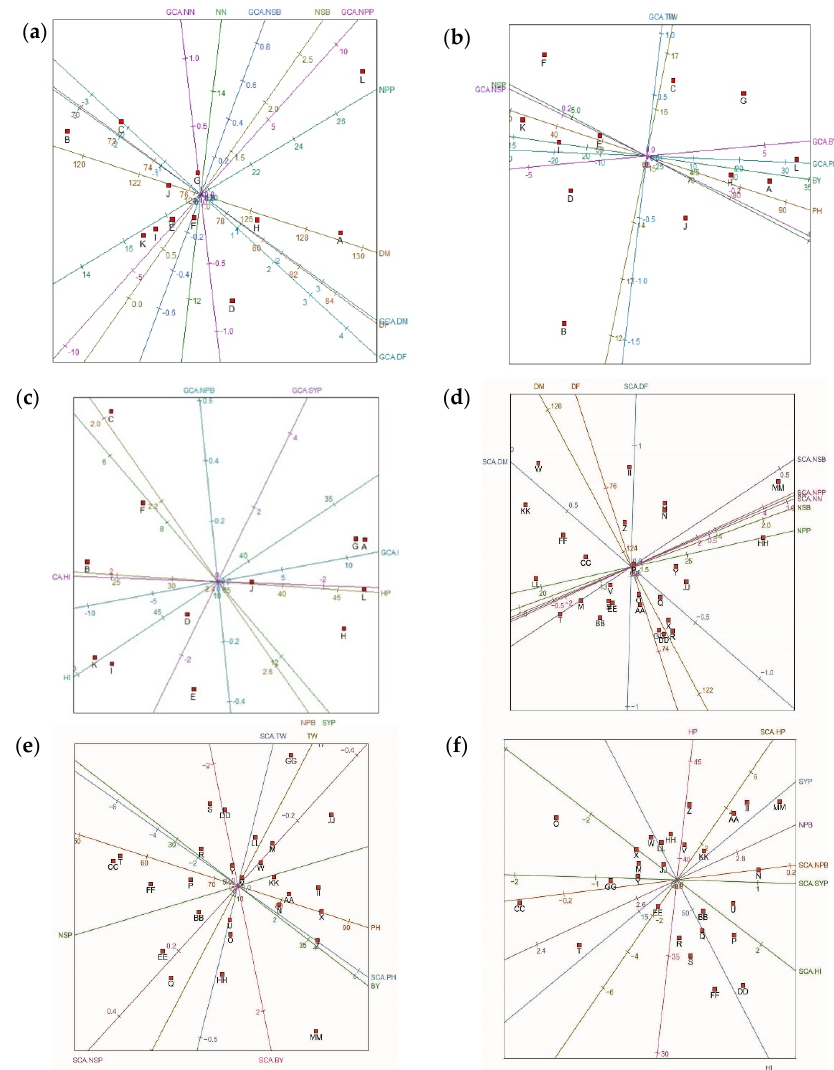
Figure 2. Principal component analysis (PCA) biplot diagrams for parents ( a – c ) and crosses ( d – f ) represent means and combining abilities.